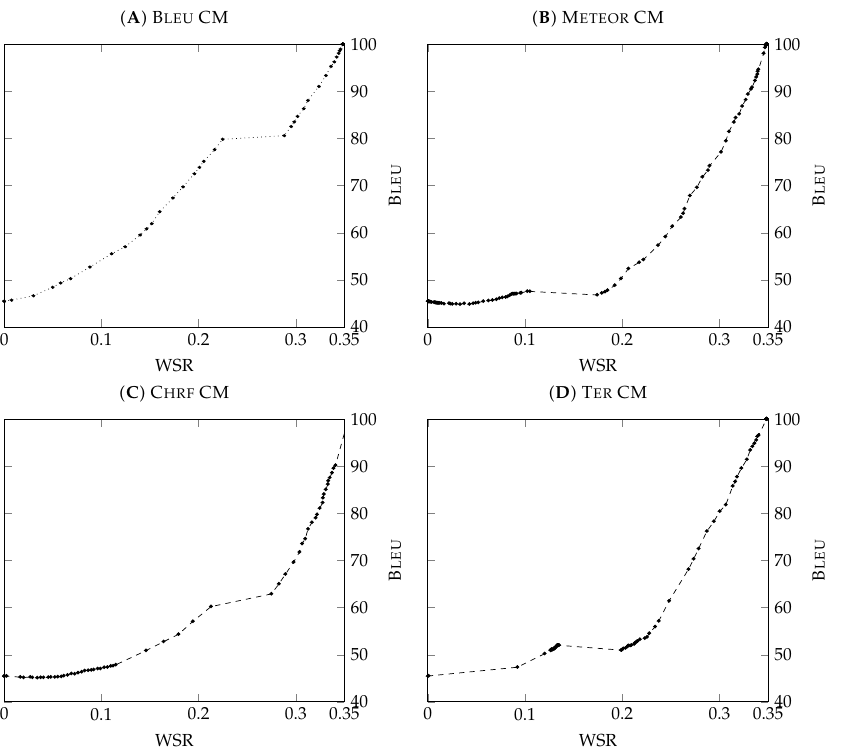
Figure 4. WSR compared with the Bleu score of the ( A ) Bleu CM, ( B ) Meteor CM, ( C ) Chrf CM, and ( D ) Ter CM. The X-axis represents the WSR score, and the Y-axis represents the Bleu score obtained with the same threshold value. The larger points are the values obtained from the experiments throughout the threshold range.